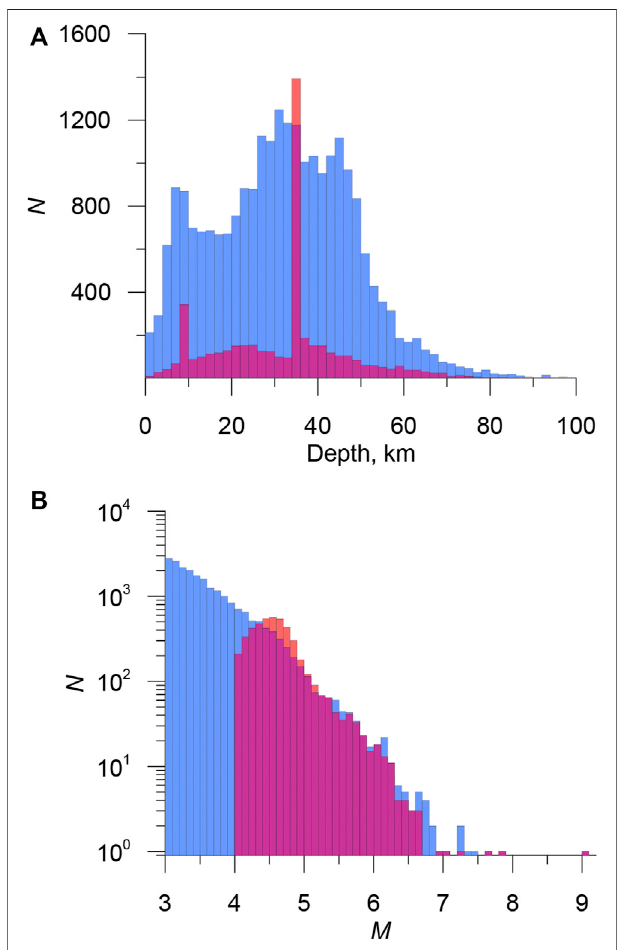
FIGURE 2 | Depth (A) and non-cumulative magnitude-frequency (B) distributions in JMA (blue) and ANNS (red) catalogs.